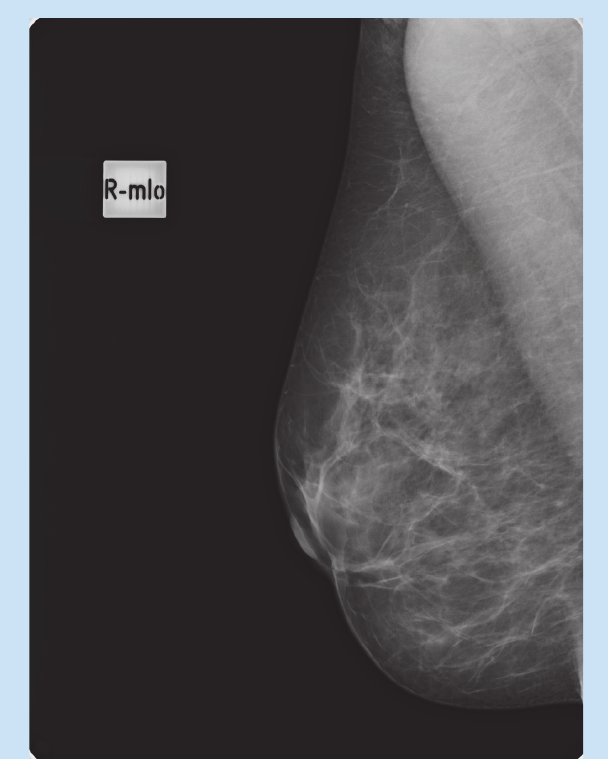
Fig. 2. Right medio-lateral oblique view.